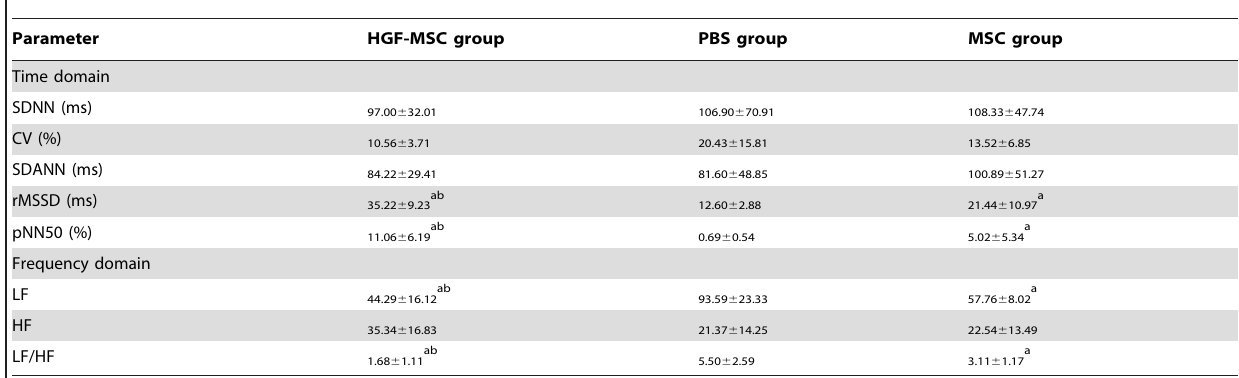
Table 2. Results of Dynamic ECG Recording for Each Group.